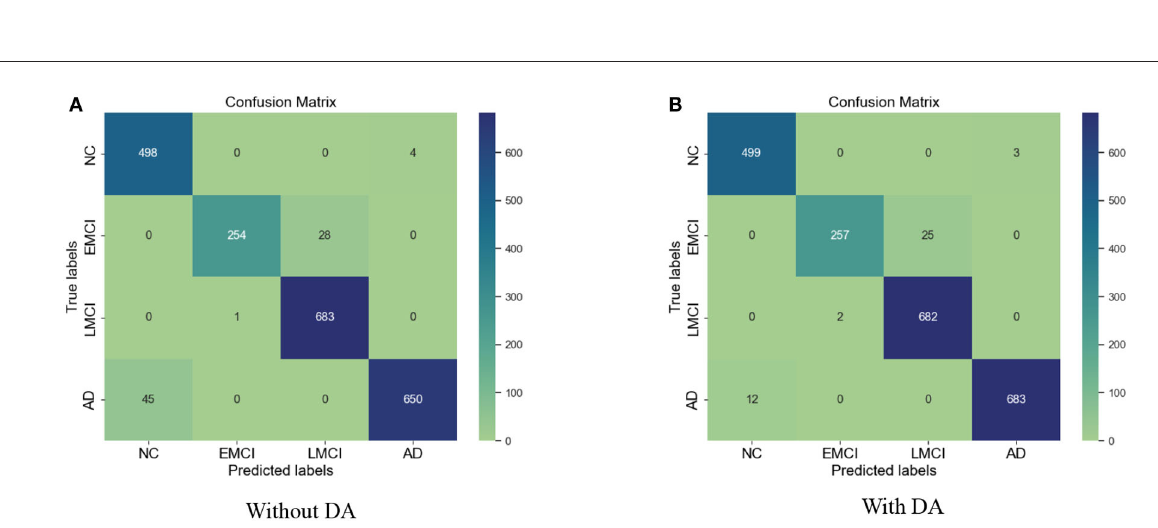
FIGURE5 (A) Confusion matrix without augmentation. (B) Confusion matrix with augmentation for the VGG 16.